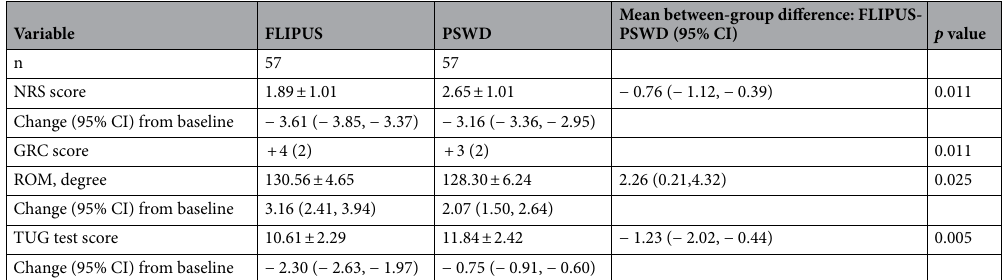
Table 3. Secondary efficacy measures after 12 days of treatment. FLIPUS focused low-intensity pulsed ultrasound, PSWD pulsed shortwave diathermy, NRS Numerical Rating Scales, GRC Global Rating of Change scale, IQR interquartile range, ROM range of motion; TUG Timed Up and Go test, CI confidence interval. Measurement data are represented as the mean ± SD (normally distributed data) or median (IQR) (nonnormally distributed data).